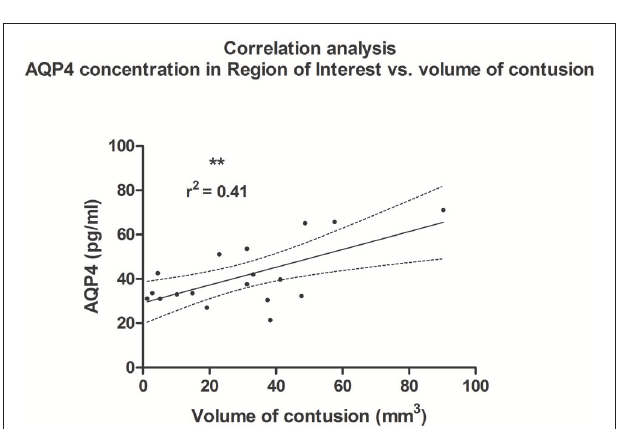
FIGURE 7 | Histogram presenting analysis of correlation between volume of contusion 24h after trauma/sham injury and AQP concentration, assessed in contralateral hemisphere at the level of injury (ROI contralateral). Similar to analysis of edema size, a correlation between increased volume of contusion and elevated concentration of AQP4 according to ELISA (r 2 = 0.41; p = 0.004; **) could be